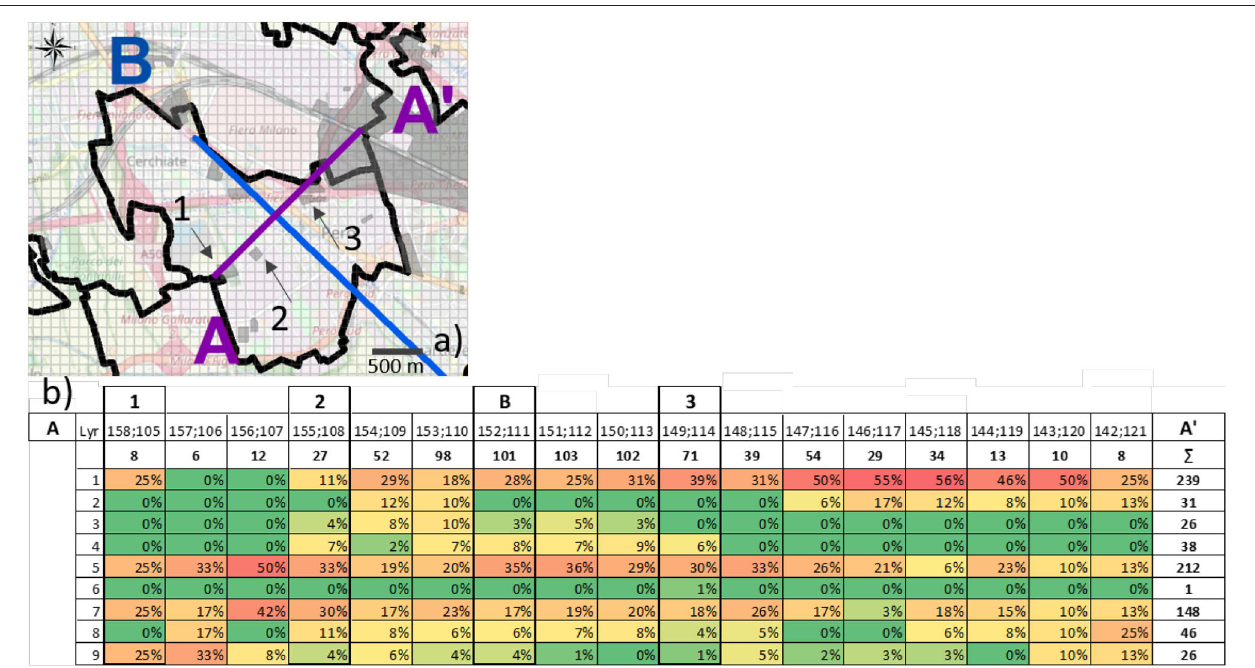
FIGURE 9 | (a) Cross-section A, oriented SW-NE (AA ′ ): line one shows the cell coordinate, line two the sum of particles passing in each vertical column and then the frequency for each layer, and the last column the count of particles for each layer; (b) zoom of Figure 7 , showing the area and three different industrial sites (1, 2, and 3). The hydrogeological cross-section is shown in the Supplementary Figure 6A